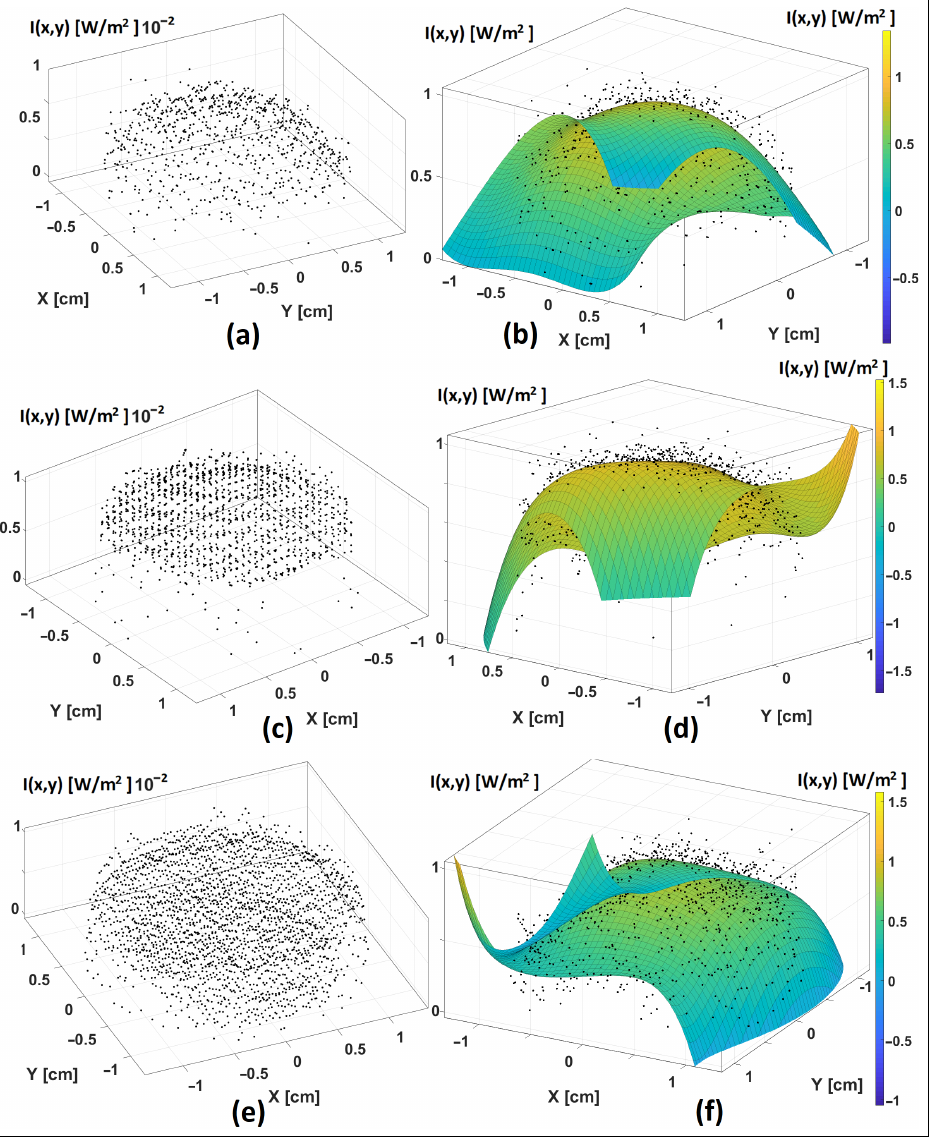
Figure 6. In ( a , c , e ) we show relative maxima for 21 transversal cuts, considering only the 50 fringes in the SGR in the simulated LCD (point cloud) for L1, L2, and L3, respectively. In ( b , d , f ), the polynomial curve fitting the point cloud in ( a , c , e ),